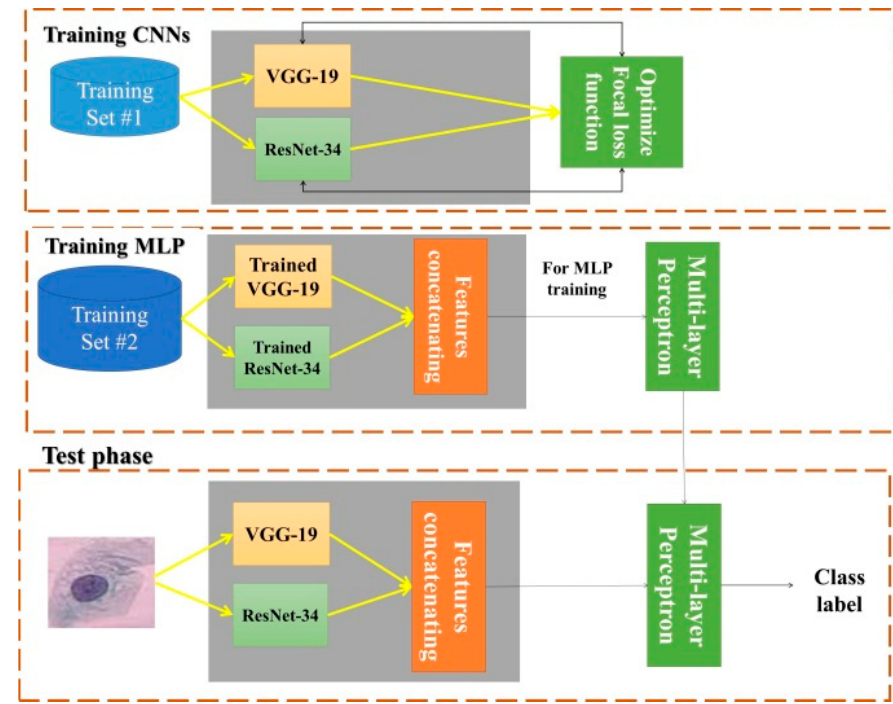
Figure 4. The main block diagram of proposed cervical cancer diagnosis method.